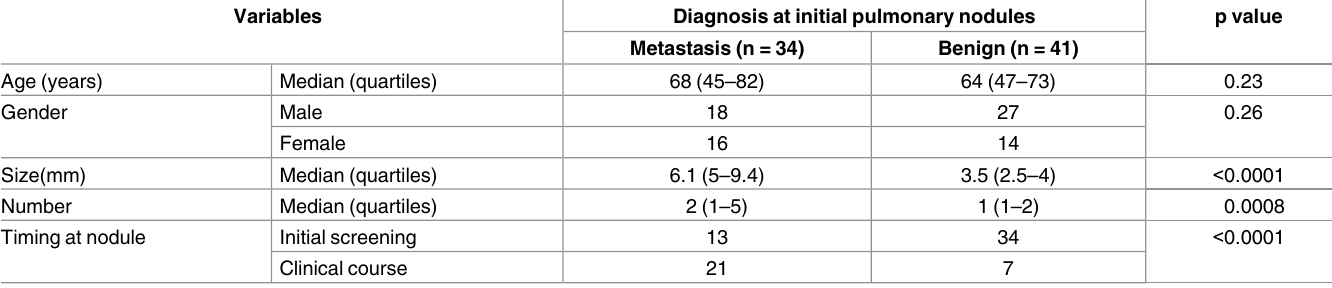
Table 1. The relationship between the final diagnosis and clinical